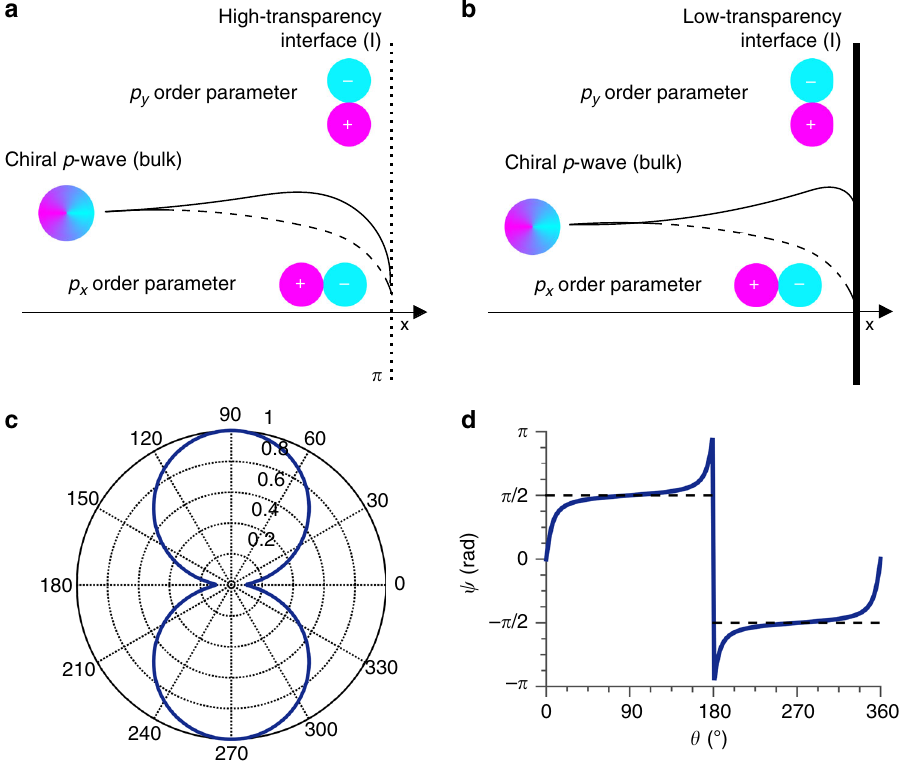
Fig. 5 Proximity-induced OP on the surface of Bi 2 Te 3 . We consider only the chiral p x + i p y part of the total p + s OP. Close to the interface I the chiral term is modi fi ed: the p x (dashed line) and p y (straight line) components exhibit different magnitude. In case of high transparency interface ( a ), the two components are both suppressed in equal manner and the resulting interface OP still preserve the p x + i p y wave character. For a low transparency interface ( b ), the p x component is highly suppressed while the p y slightly enhanced. The resulting OP has a predominantly p y character. c shows the amplitude of the resulting interface OP by considering a mixture p y + i α p x , with α = 0.1. This corresponds to the reduction of p x on distances of the order of the coherence length of S ′ 28 . The corresponding phase is shown in d lobes of the same sign with each other) give a conventional 0 coupling. The schematics of the scattering processes are shown in Fig. 6b. The net result is that the total supercurrent is partially canceled by these competing contributions, which amounts to a suppressed I C at zero fi eld.